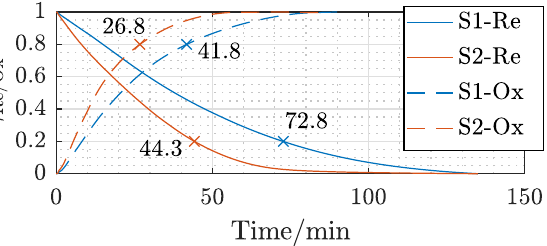
12.7mm) and S2 ( d s2 9.8mm) on the temporal reduc- ≈ ≈